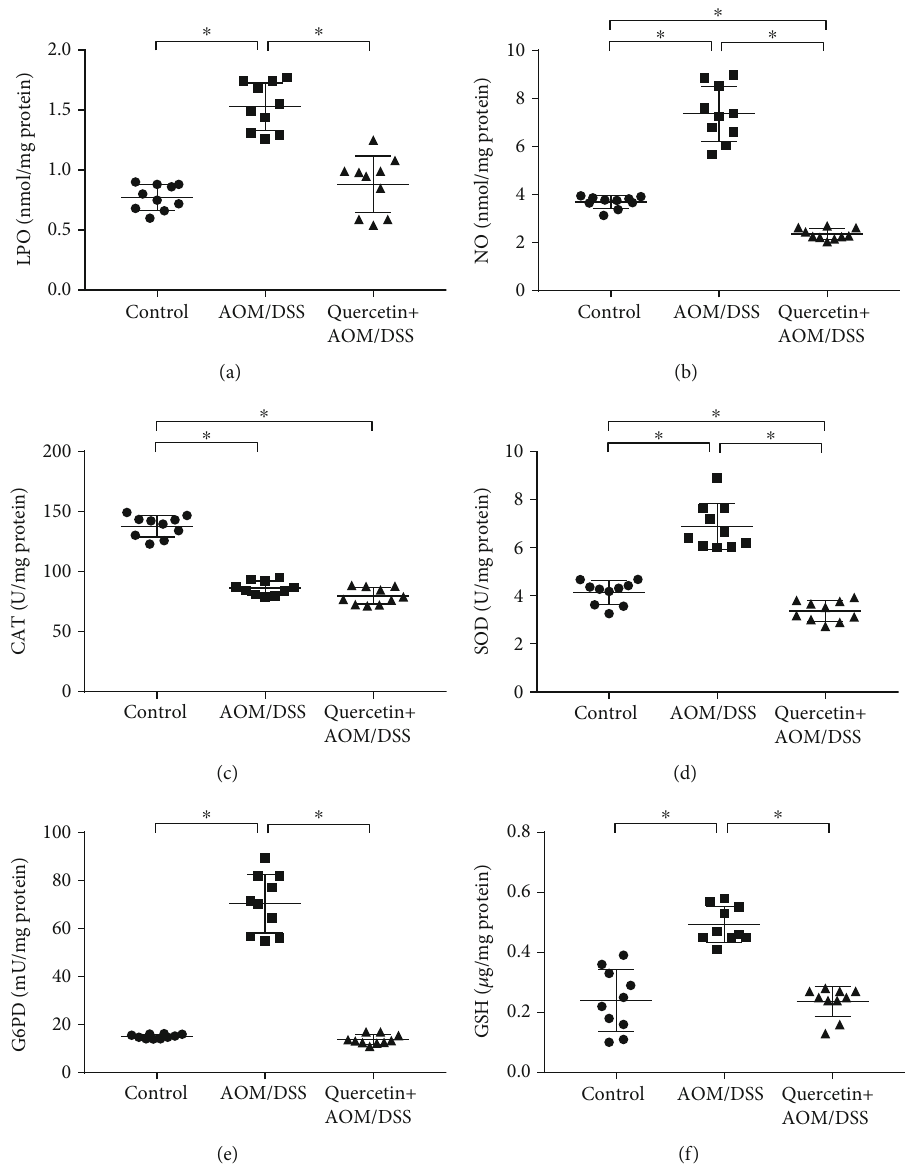
Figure 5: Quercetin reduces oxidative stress in AOM/DSS-treated mice. (a) Quanti fi cation of the LPO expression level in control and experimental mice colon tissues. (b) Quanti fi cation of the NO expression level in control and experimental mice colon tissues. (c) Quanti fi cation of the CAT expression level in control and experimental mice colon tissues. (d) Quanti fi cation of the SOD expression level in control and experimental mice colon tissues. (e) Quanti fi cation of the G6PD expression level in control and experimental mice colon tissues. (f) Quanti fi cation of the GSH expression level in control and experimental mice colon tissues. Data are expressed as mean values ± SD ( n = 10 /group). ∗ P < 0 : 05 , Student ’ s t